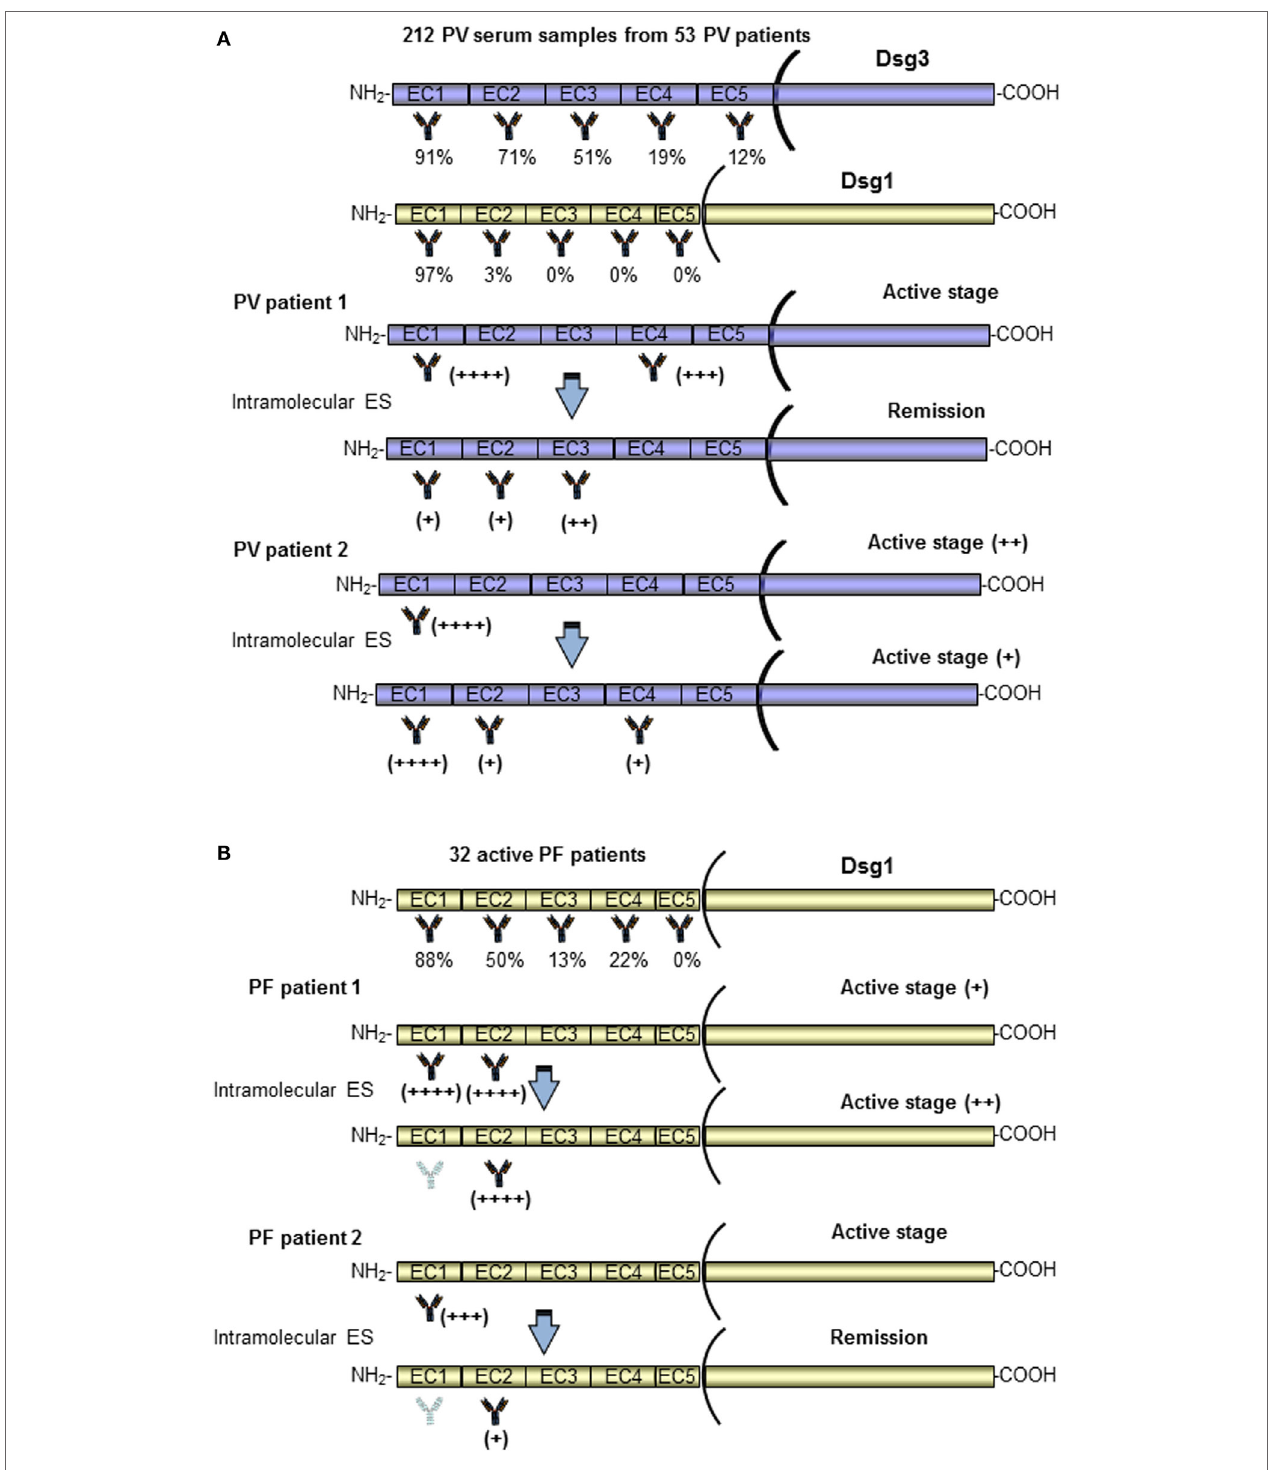
FiGURe 3 | Pemphigus vulgaris (PV) and pemphigus foliaceus (PF) patients present Dsg3 and Dsg1 epitope profiles stable over the disease course. A schematic representation of the antigenic regions recognized by autoantibodies of a PV (A) and PF (B) patients at diagnosis, with relative percentage of reactivity, and during the disease course (20, 21). Only two patients (for PV and PF) in whom epitope spreading (ES) phenomenon occurred have been shown. In most PV and PF patients, the major Dsg3 and Dsg1 epitopes are localized in the EC1–2 subdomains. In the vast majority of PV and PF patients, the epitope profile remained stable during the course of the disease. Of note, two patients (PV patient 1 and PF patient 2) in active stage reacted to EC1 and shifted with an intramolecular ES to other subdomains (EC2/EC3 and EC2) (20, 21).